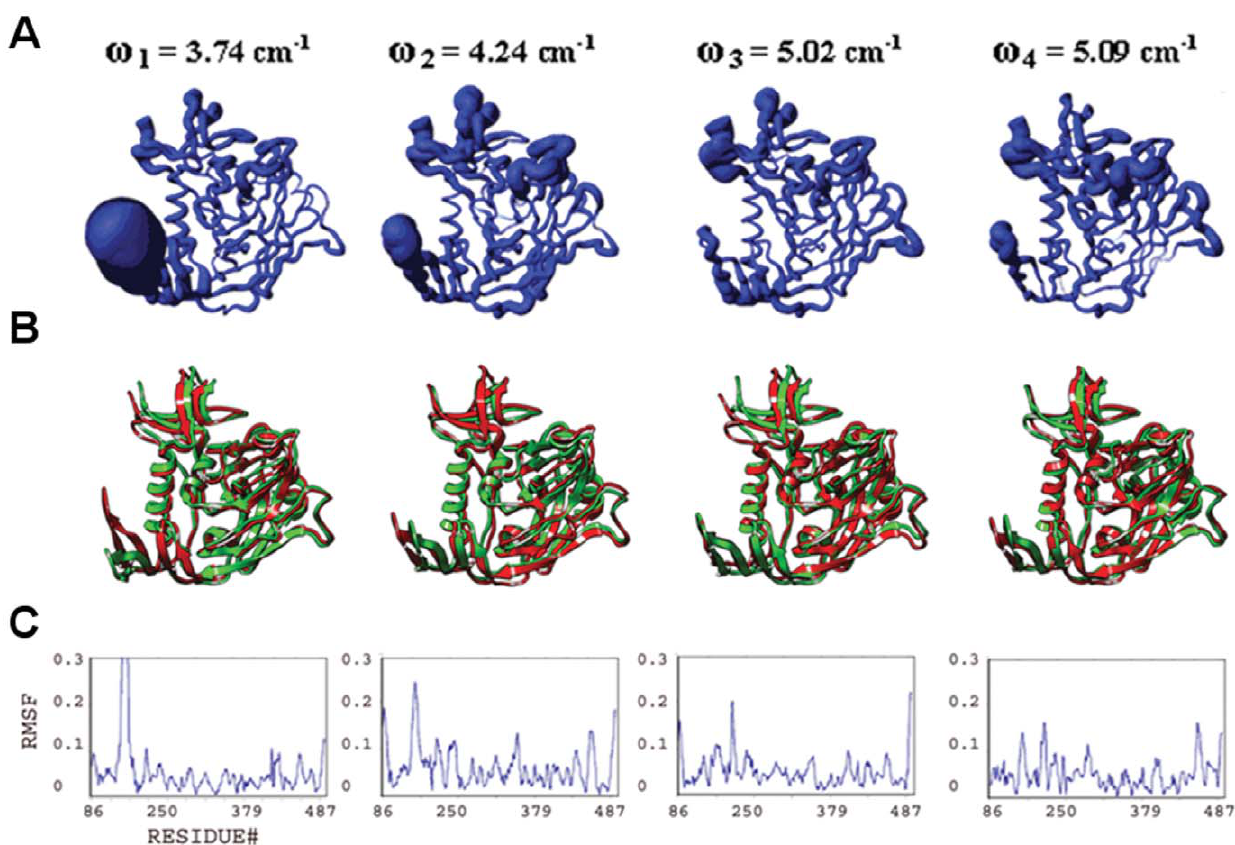
Figure 3. Conformational plasticity of isolated gp120. Features are shown for the four slowest modes from a full atomic normal mode analysis in a solvent shell. ( A ) Fluctuations from frequency-weighted slow modes are mapped onto worm diagrams depicting the course of the polypeptide backbone of HIV gp120. The thickness of each worm is proportional to the amplitude of the calculated fluctuations. ( B ) Superposition of conformers (red and green) generated at extremes of the fluctuations (The relative amplitude of fluctuations define the limits of the excursions on gp120; see Methods). ( C ) Alpha-carbon root-mean-square fluctuation (RMSF) plots.